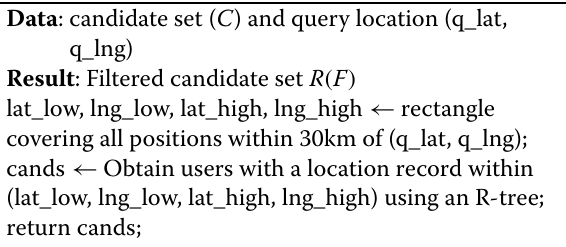
Algorithm 2: Location-based pre-processing